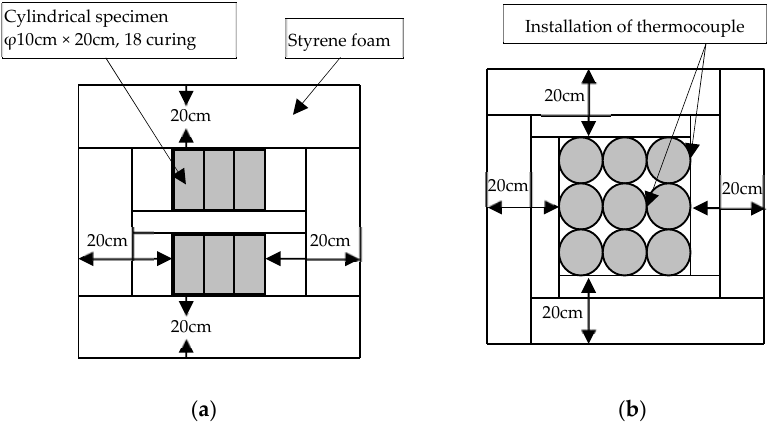
Figure 2. Simple adiabatic curing method: ( a ) side view and ( b ) plain view. Table 8. Qualities of fresh concrete.